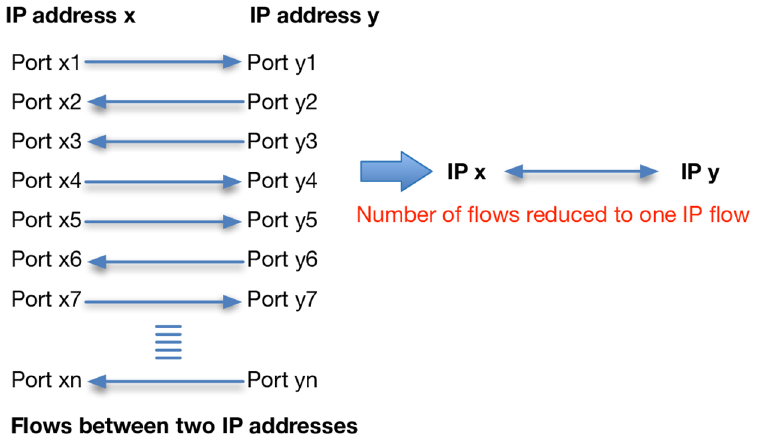
Fig 3. Conflation of multiple traffic flows to one IP flow. Seven traffic flows between different ports on the same sending and receiving hosts are reduced to a single IP flow.